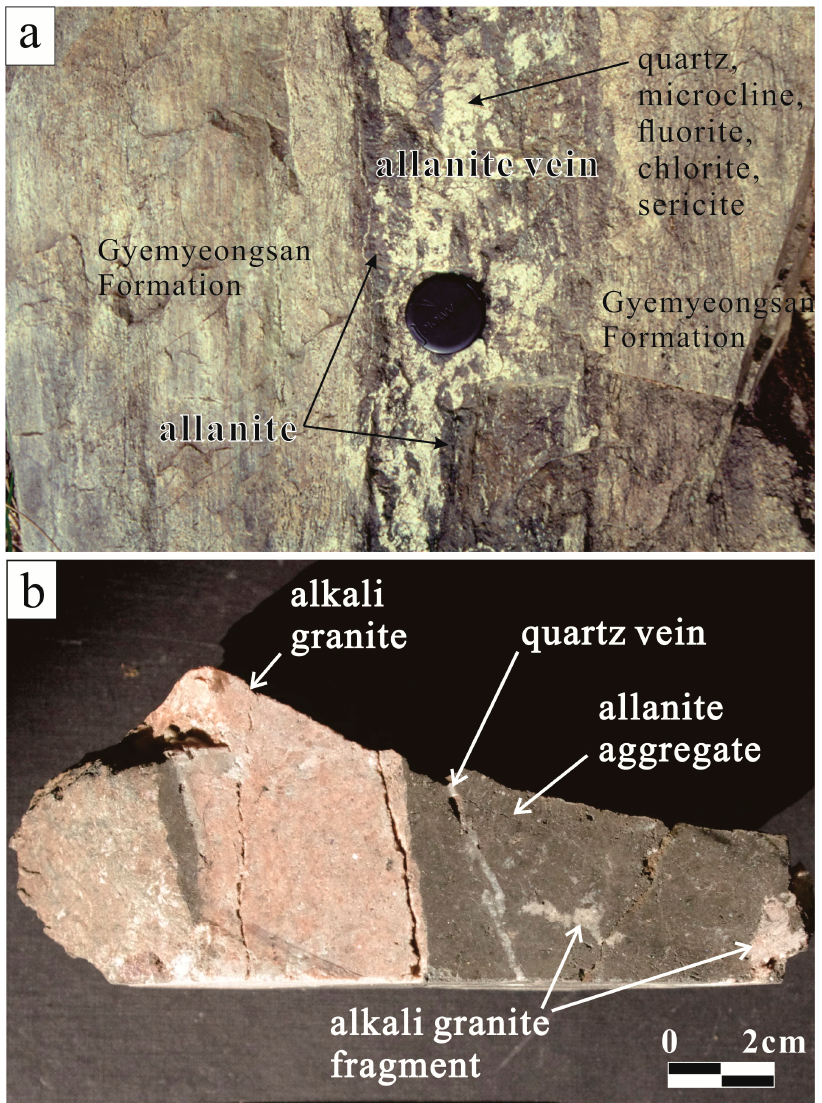
Figure 2. Allanite vein intrusion in the Gyemyeongsan Formation and in alkali granite. ( a ) The allanite vein consists of allanite aggregates and felsic minerals. ( b ) The sharp contact between the alkali granite and allanite vein composed of allanite aggregates, fragments of alkali granite, and the latest quartz vein.